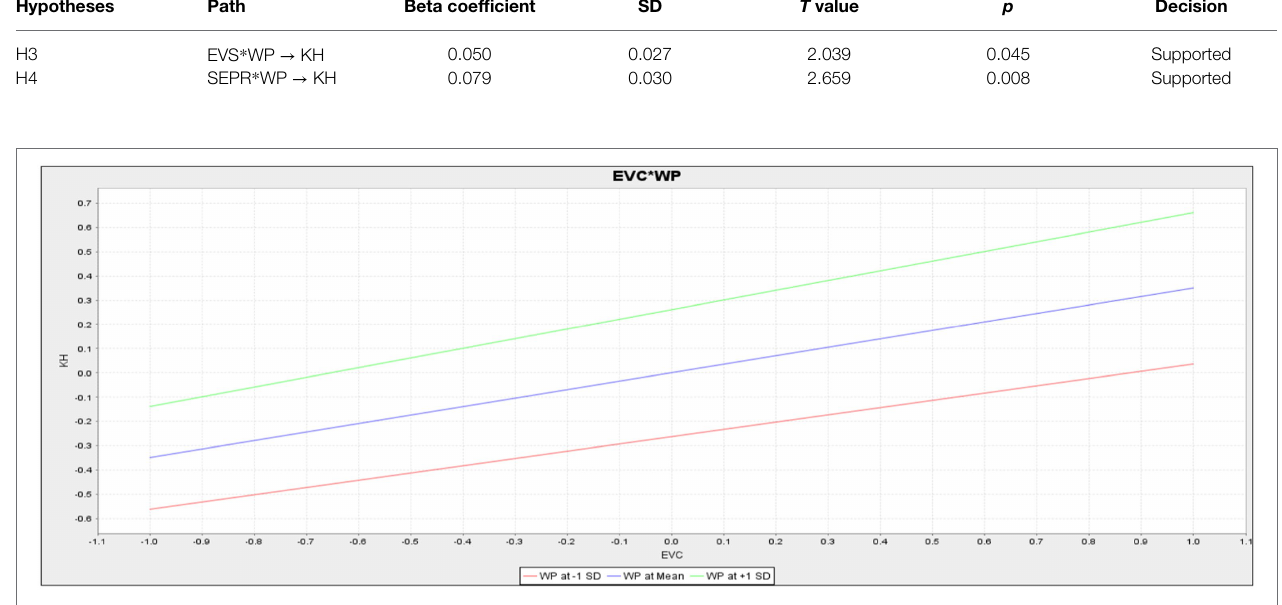
FIGURE 3 | A slope for ethical value congruences (EVC) and workplace friendship